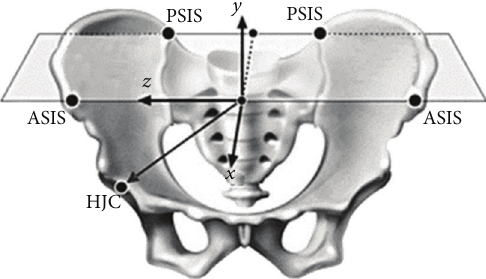
Figure 6: Anatomical structure of the pelvis showing HJC location.